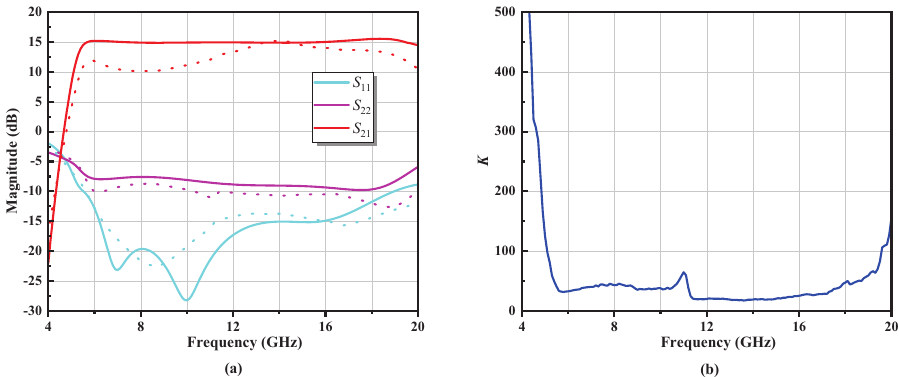
Figure 10. Experimental results of the proposed driver amplifier. ( a ) Comparison between simulated (solid line) and measured (dash line) small-signal performance. ( b ) Measured stability factor of the driver amplifier.